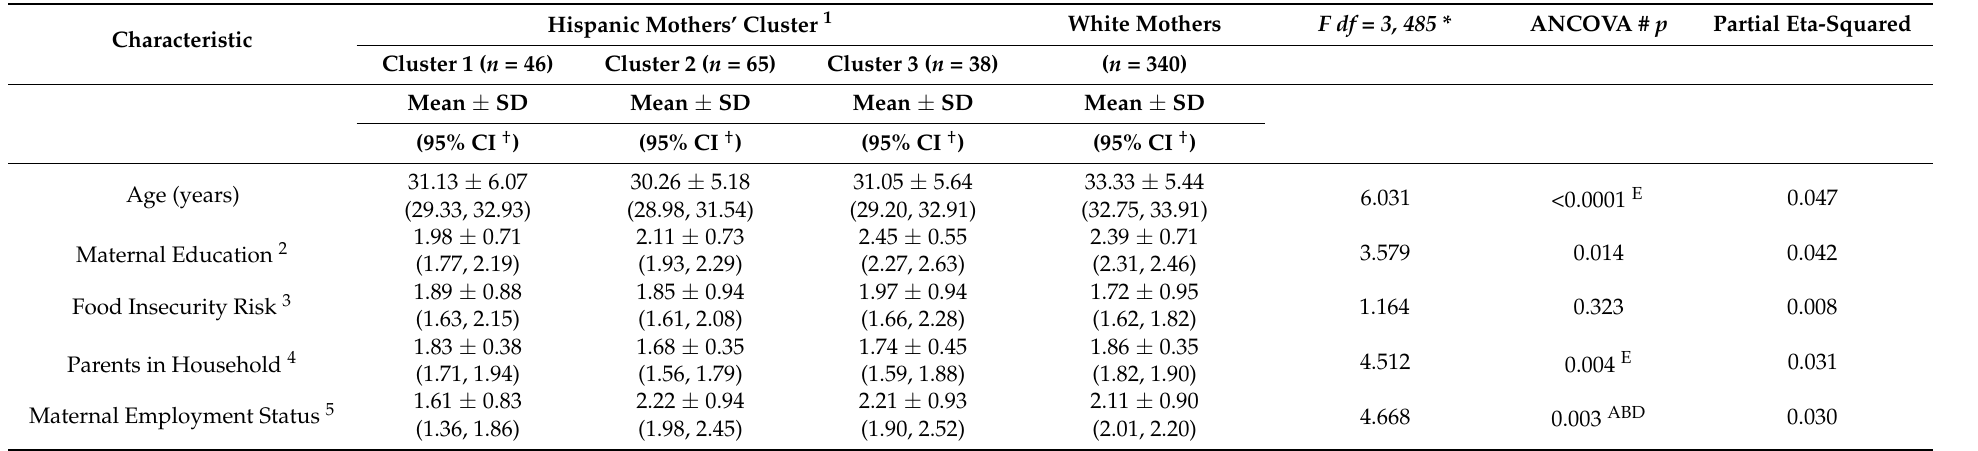
Table 3. Demographic Characteristics of Mothers ( n =